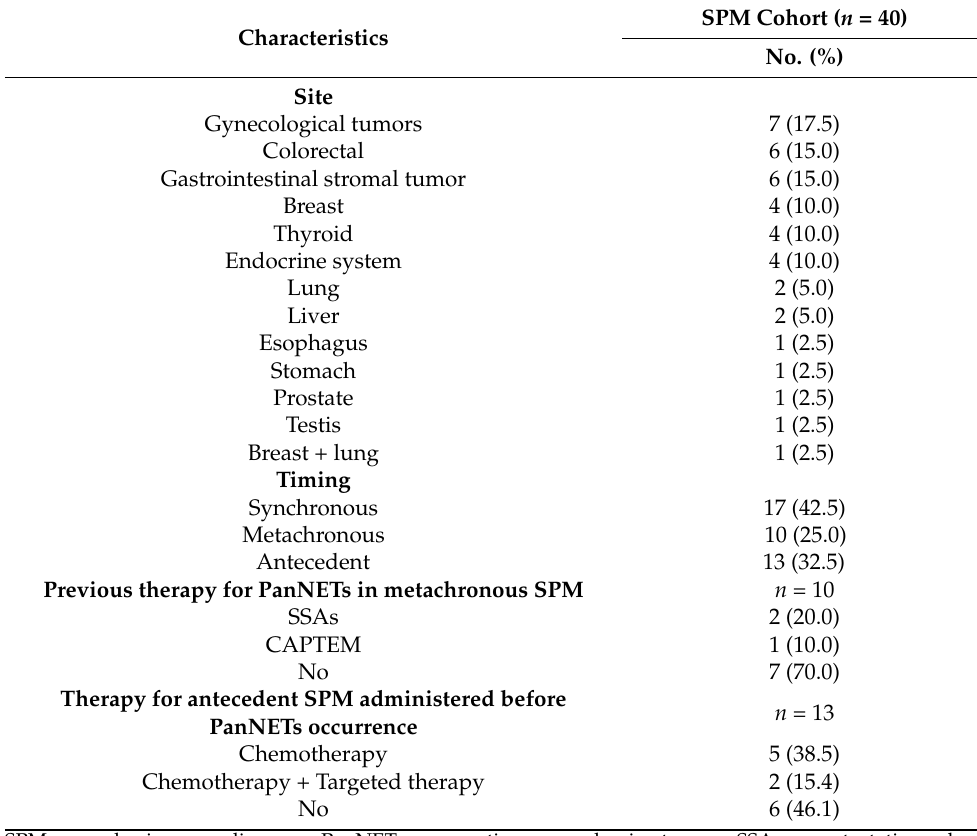
Table 3. Characteristics of the second primary malignancy